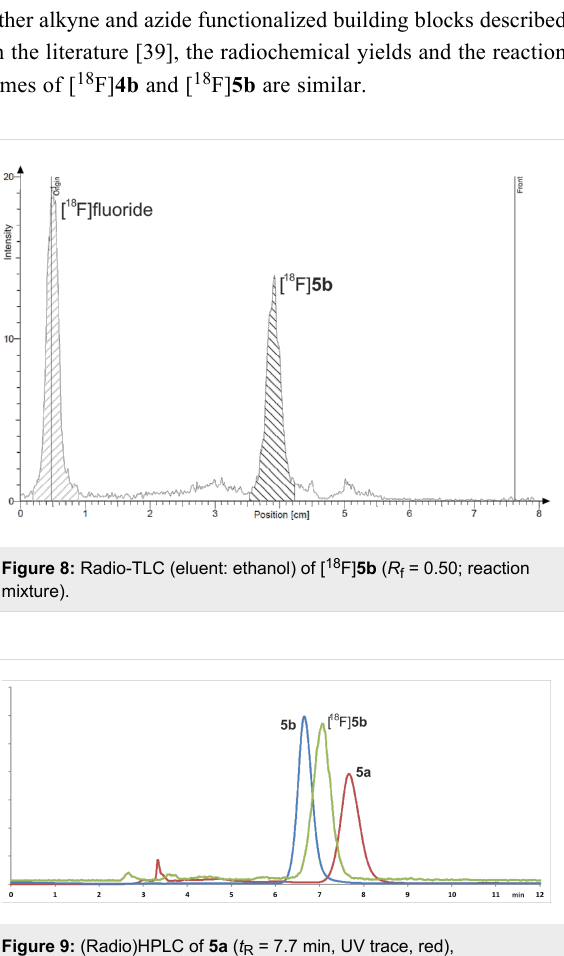
Figure 9: (Radio)HPLC of 5a ( t R = 7.7 min, UV trace, red), 5b ( t R = 6.7 min, UV trace: blue) and [ 18 F] 5b ( t R = 7.1 min, γ -trace, green). The differences in the retention times of 5b and [ 18 F] 5b occurs due to the setup of UV- and γ -detector of the HPLC